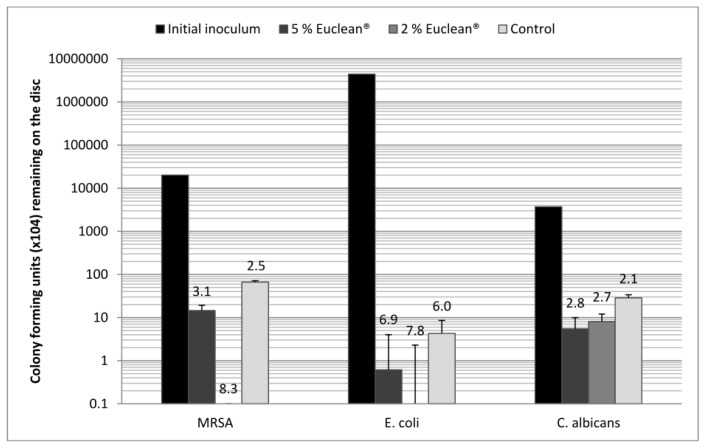
Reduction in mean (n = 3) cfu per disc of a panel of microorganisms dried onto stainless steel discs following wiping with 5% and 2% EO-containing wipes and control wipes, with the log reduction from the initial inoculum and standard deviation.